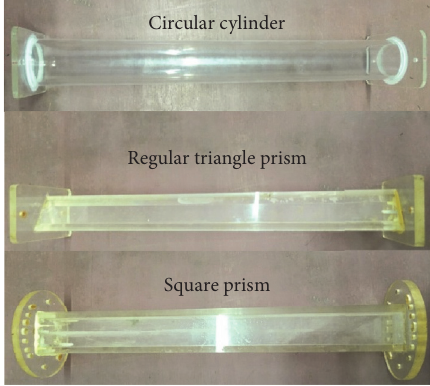
Figure 4: The physical models of cylinders or